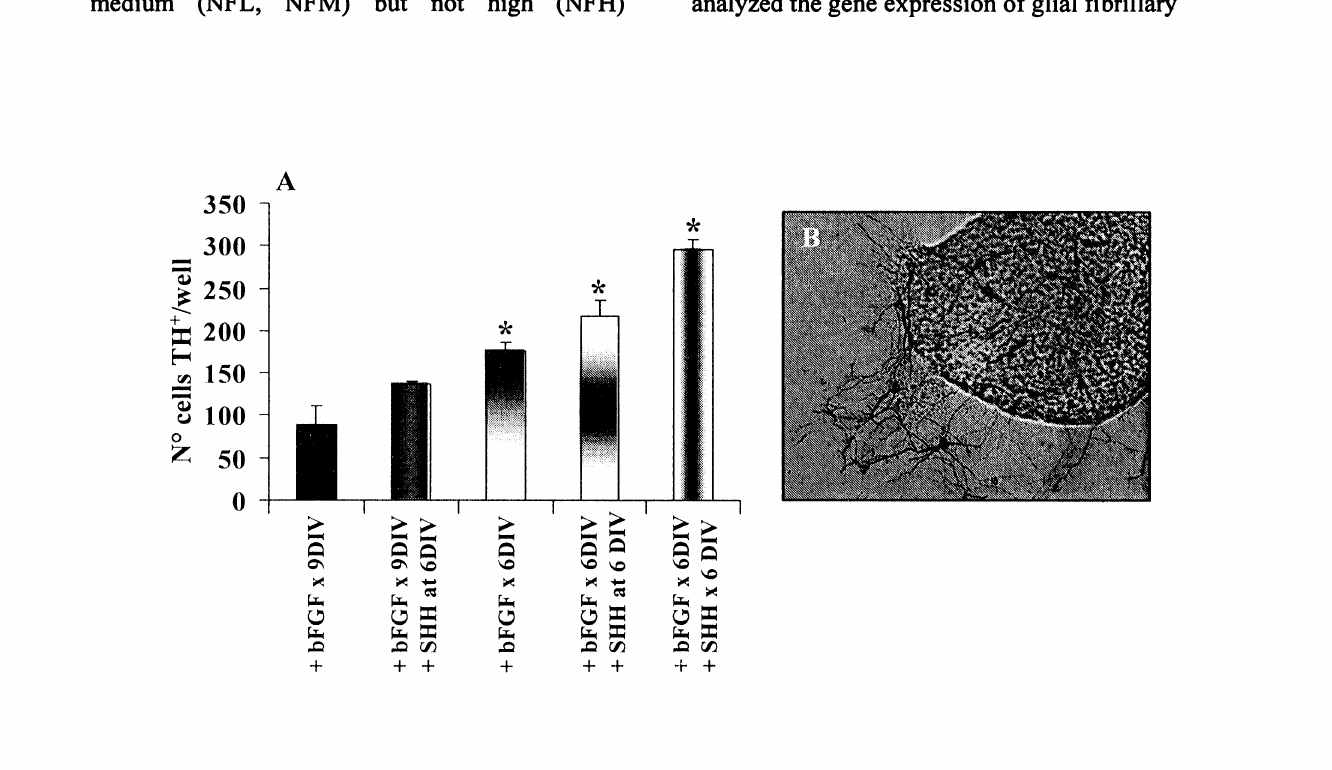
Fig. 2: Characterization of expanded MES DA cultures. (A): Number of TH cells in 9 DIV cultures treated with bFGF (20 ng/ml) for 9 DIV (+bFGF x 9 DIV), with bFGF for 9 DIV and addition of SHH (50 ng/ml) at 6 DIV (+bFGF x 9 DIV, +SHH at 6 DIV), with bFGF for 6 DIV (+bFGF x 6 DIV), with bFGF for 6 DIV and subsequent addition of SHH at 6 DIV (+bFGF x 6 DIV, + SHH at 6 DIV) or plated in the presence of both bFGF and SHH which are subtracted at 6 DIV (+bFGF x 6 DIV, +SHH x 6 DIV). The bars represent the mean +/- SEM of triplicate samples for each experimental point. Asterisks represent p<0.01 when compared to cultures treated with bFGF for 9 DIV (ANOVA, Scheff6 F-test). (B): TH-immunoreactive neurons at 9 DIV, after stimulation with bFGF and SHH for 6